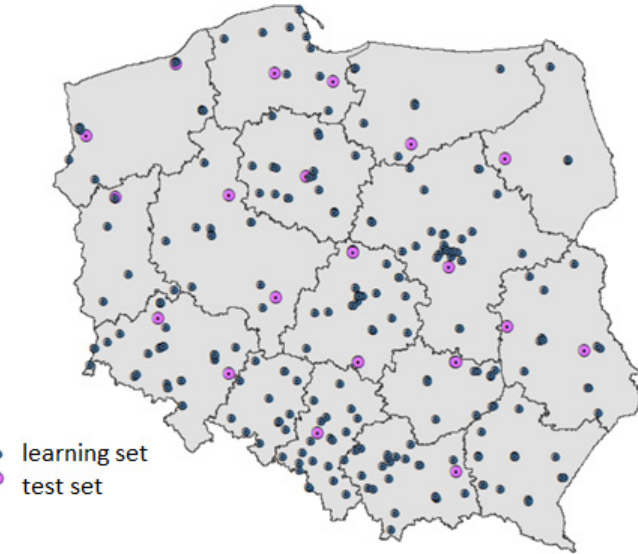
Fig. 4. Distribution of measuring points in Poland and division into a learning set (smaller, gray symbols) and a test set (larger, purple